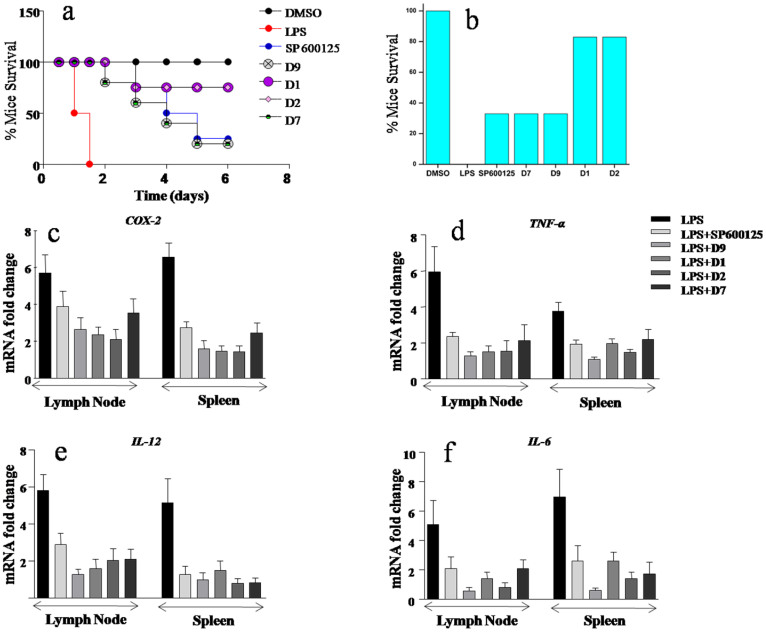
Anthrapyrazolone analogues block LPS induced inflammation in vivo.(a) LPS induced inflammation is inhibited by intravenous administration of the inhibitors as mentioned in materials and methods. Viability of mice is monitored at regular time intervals (no. of mice per each group = 6). (b) Bar graph representation of % mice survival data as given in (a). (c, d, e & f) Real Time PCR analysis of COX-2, TNF-α, IL-12 & IL-6 respectively in lymph nodes and spleen of mice injected with small molecule inhibitors. Representative blots of three independent experiments were shown. n = 3, SE ± mean.